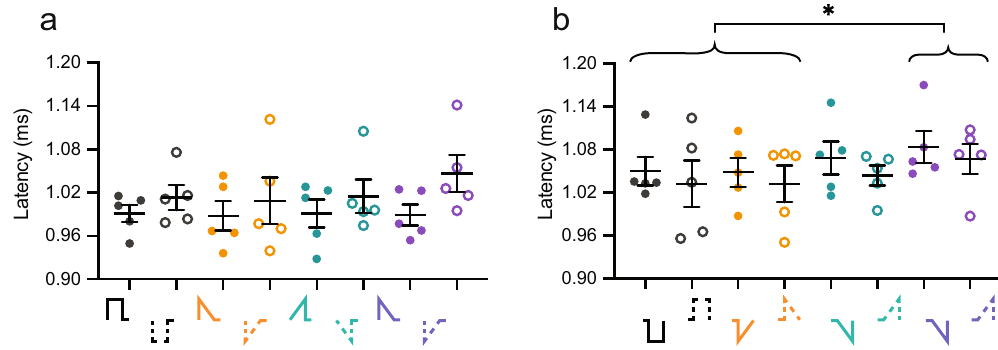
Figure 6. Monophasic ramped and rectangular pulse shapes evoke similar wave II latencies. ( a ) Latency of wave II evoked by the first, monophasic phase at three dB above threshold. ( b ) Latency of wave II evoked by the second, monophasic phase at three dB above threshold. Asterisk denote significant effect in post-hoc test of the factor pulse shape (Tukey HSD). * p ≤ 0.05. n = 6. Error bars are